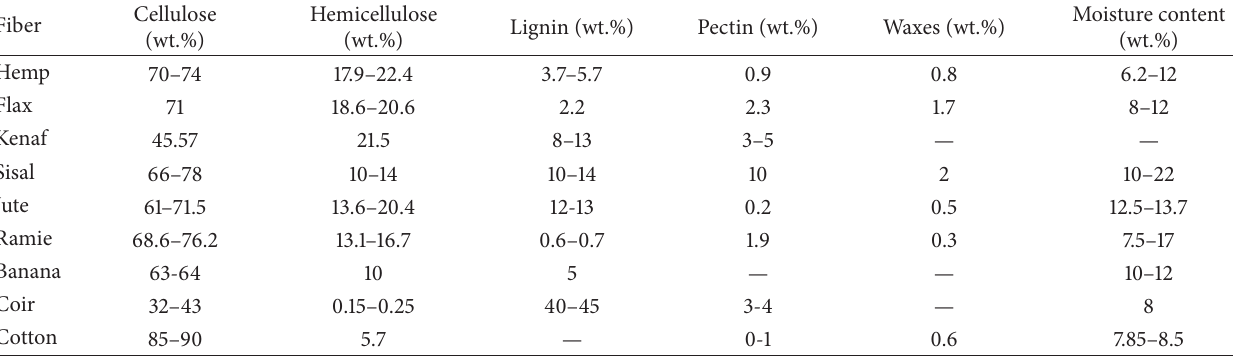
Table 1: Chemical composition and moisture content of some vegetable fibers [16, 17].